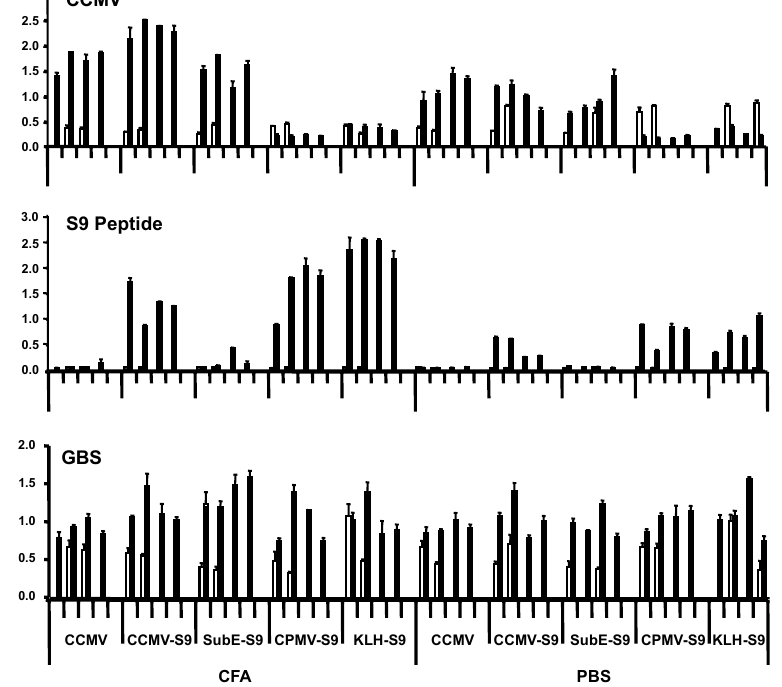
Figure 2. Production of antibody to CCMV, S9 peptide, and GBS by mice immunized with different immunogens. Groups of four mice were immunized with ssCCMV VLPs, ssCCMV VLPs conjugated to S9 peptide, subE (monomeric capsid) conjugated to S9 peptide, CPMV VLPs conjugated to S9 peptide, and KLH conjugated to S9 peptide. Mice were immunized either with Freund’s adjuvant, or in the absence of adjuvant. The results of individual mice are shown. Prebleeds are in open bars, sera obtained following immunization in solid bars. ELISA plates were coated with the indicated antigens. Sera were tested at 1:1000 dilution for CCMV, 1:5000 for S9 peptide, and 1:200 for GBS. Binding was detected with alkaline phosphatase conjugated anti-mouse IgG (H + L). Antibodies of all isotypes are detected because of the L chain specificity of the conjugated antiserum.